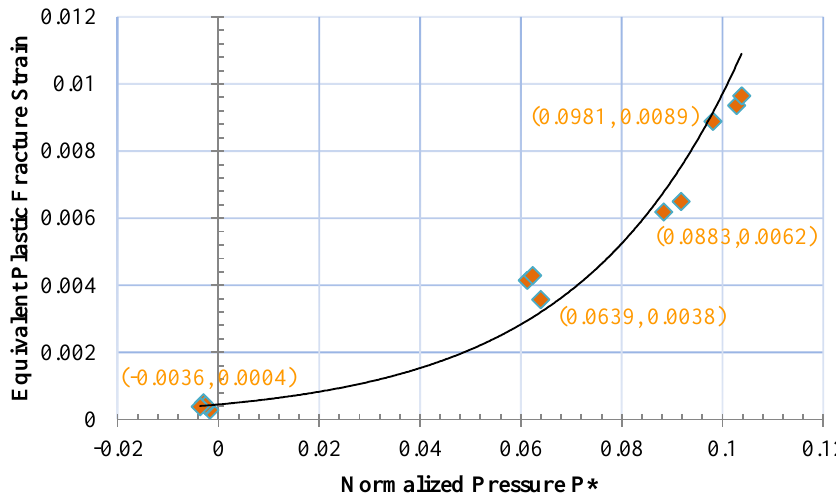
Figure 7. Relation of equivalent plastic strain failure against hydrostatic pressure for granite. Table 1. Parameters of Barre granite and